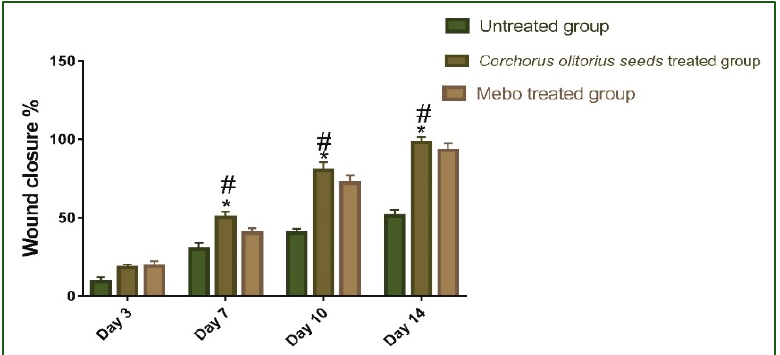
Figure 4. Wound closure rates in all tested groups (group 1: untreated group bare control ( n = 8), group 2: Corchorus olitorius seed extract -treated group ( n = 8), group 3: Mebo-treated group ( n = 8)) over time post-injury (0, 3, 7, 10, and 14 days). Significant difference between groups is analyzed by a two-way ANOVA test after normalization of variables by the Shapiro–Wilk test. Data were expressed as mean ± SD. * p ≤ 0.001 compared with those of the untreated group on the respective day and # p ≤ 0.001 compared with those of the Mebo group on the respective day.